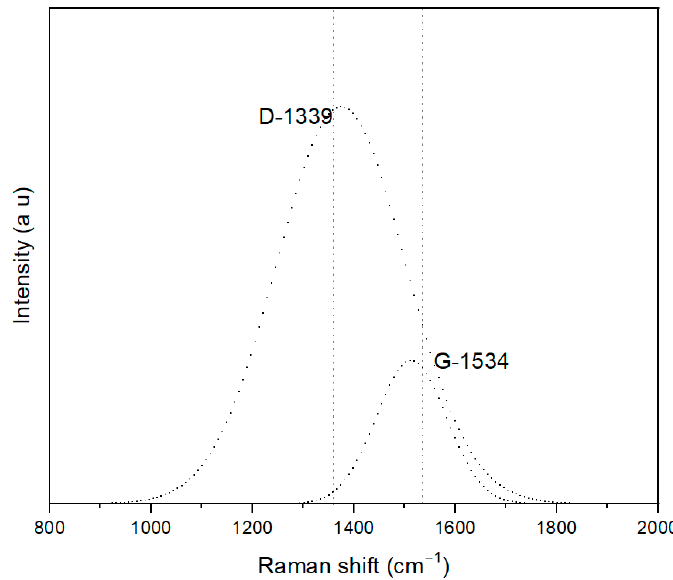
Figure 1. Raman spectrum for the HfCN coating.